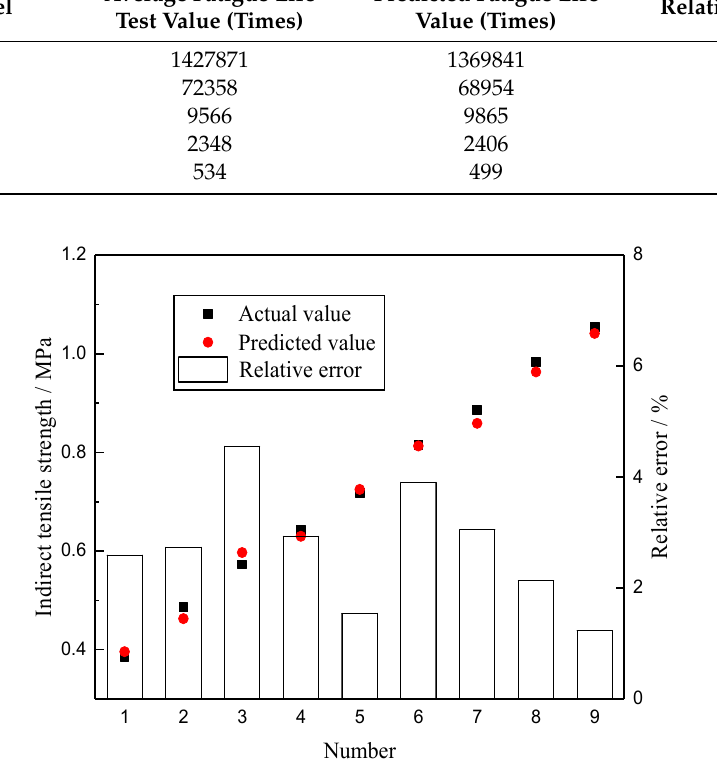
Figure 10. Validation results of the strength prediction model. Table 13. Verification results of the fatigue prediction model.